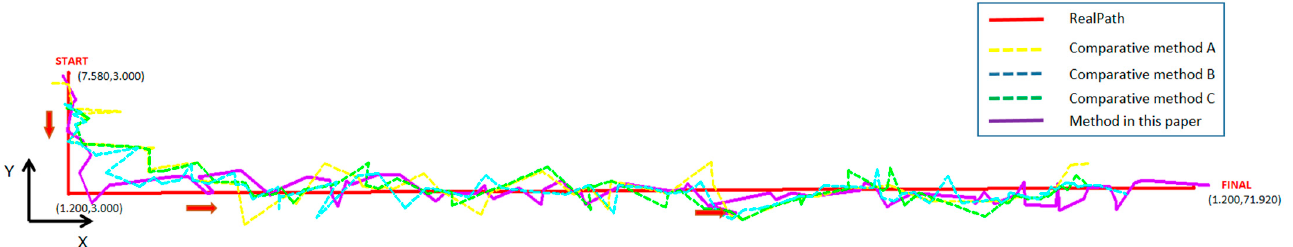
Figure 10. Positioning results for the comparator methods.